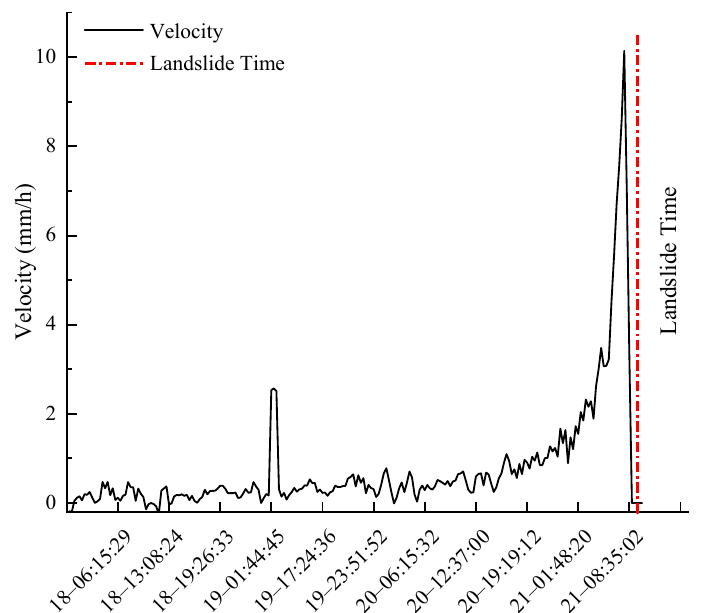
Figure 10. Velocity curve.